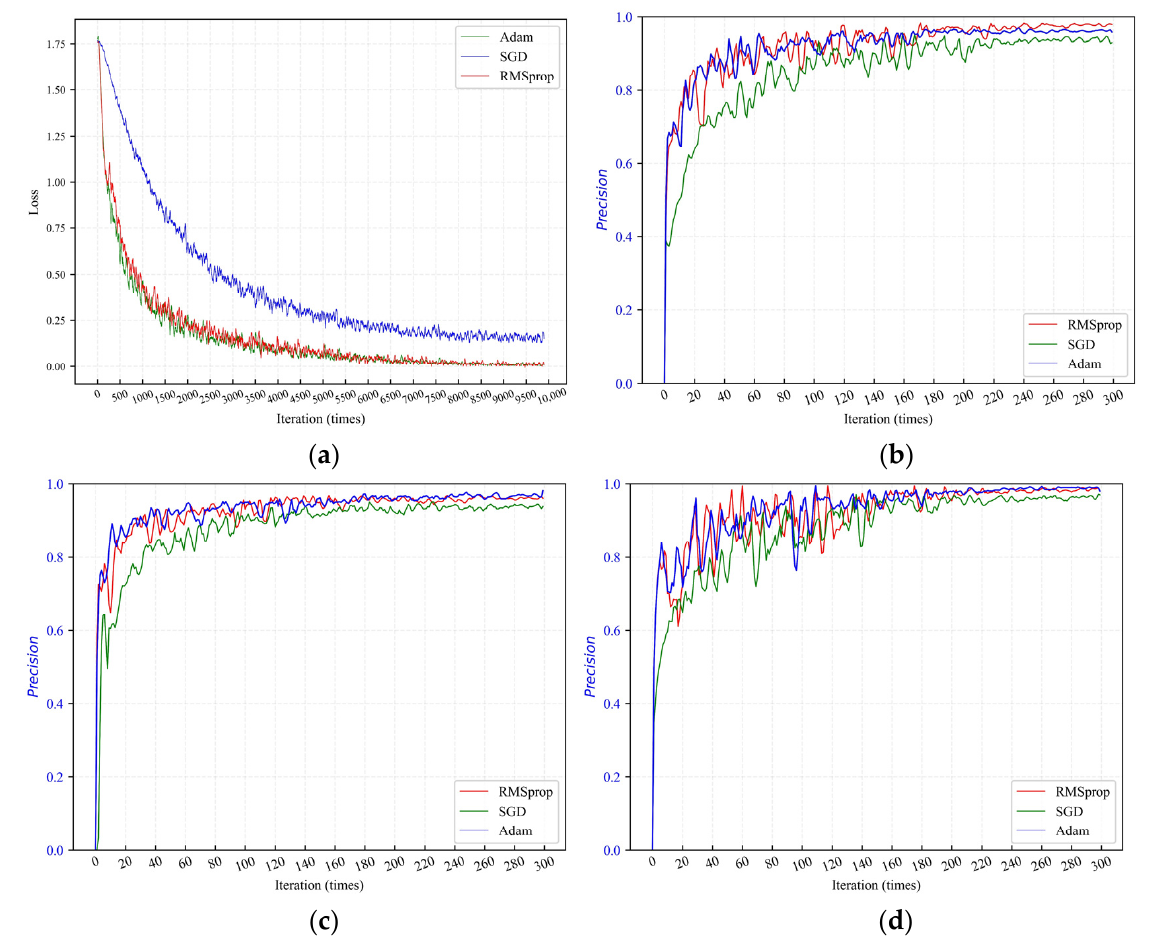
Figure 9. ( a ) Training loss of GoogLeNet under three optimizers; ( b ) classification precision of metamorphic rock under three optimizers; ( c ) classification precision of sedimentary rock; and ( d ) classification precision of volcanic rock.